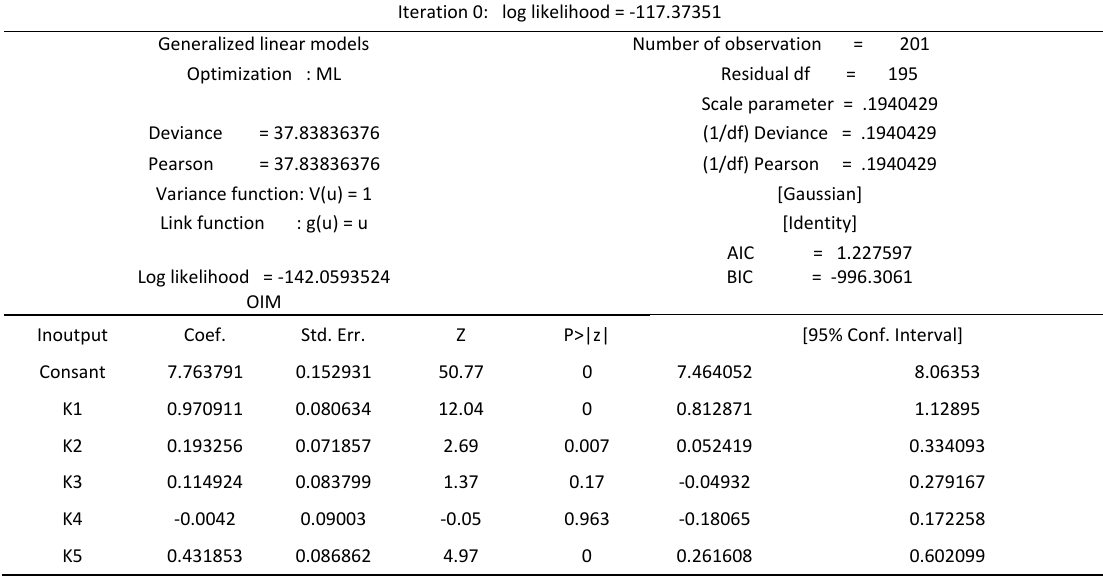
Table 4: Results for the restricted log‐likelihood test